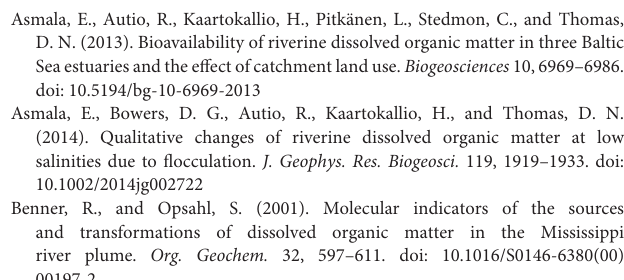
Figure S1 | Seasonal patterns of DOM quality predicted for average DOC in the different estuaries (Karjaanjoki 465, Kiiminkijoki 688, and Kyrönjoki 1026 µ mol L − 1 ). (A) SUVA 254 ; (B) Slope 275–295nm; (C) Fluorescence peak A; (D)